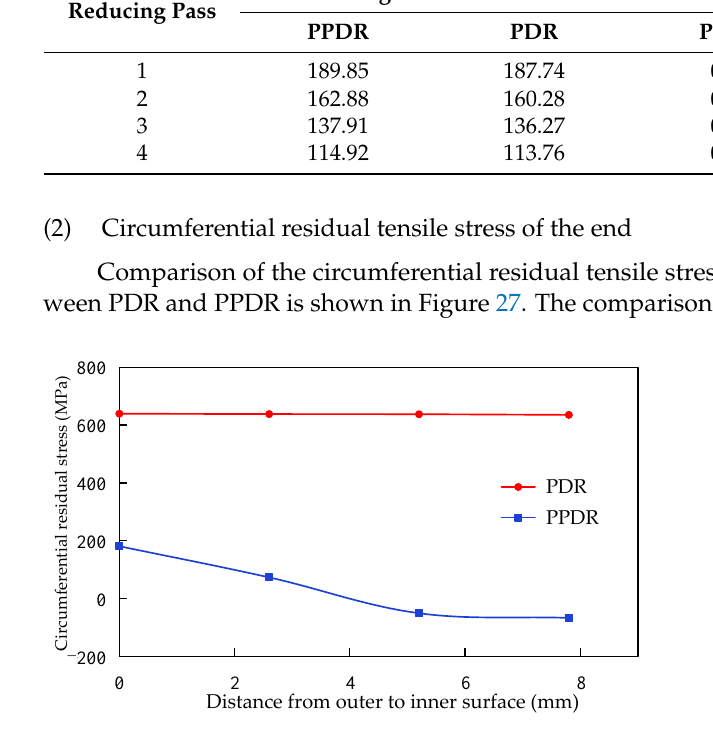
Figure 27. Circumferential residual stress of end.